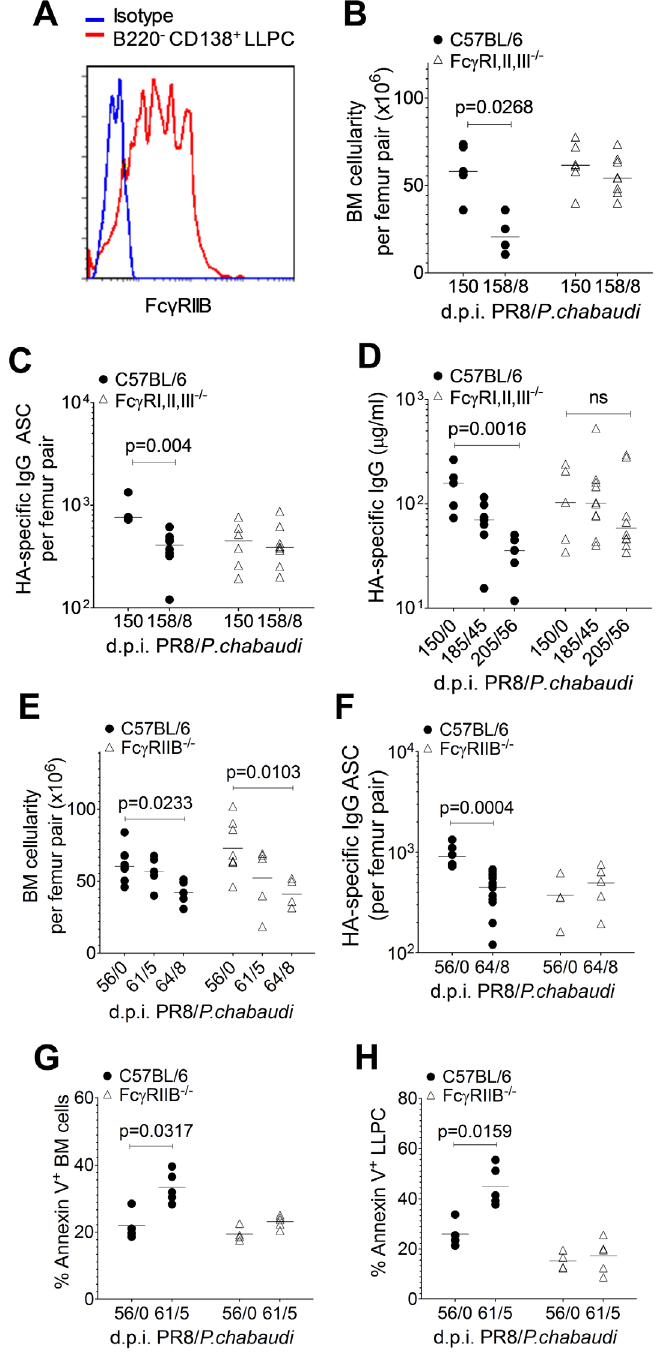
N ) and Fc c RI,II,III 2 / 2 ( D ) Figure 4. Loss of pre-existing humoral immunity to Influenza A virus is dependent on Fc c RIIB. Female C56BL/6 ( mice aged 8–10 weeks were infected by intranasal instillation of 250 HAU of PR8. 150 days later, mice were infected with P. chabaudi . A. Representative FACS plot showing the relative MFI of Fc c RIIB (CD32) expression on B220 2 CD138 + bone marrow LLPCs compared to an isotype control. B and C 8 days after P. chabaudi infection, bone marrow from femur pairs was obtained. B. Total bone marrow cellularity was determined N ): n=3 (d150/0) and 8 (d158/8)]. and C, HA-specific ASCs were quantified using ELISpot [Fc c RI,II,III 2 / 2 ( D ): n=6 (d150/0) and 8 (d158/8); C56BL/6 ( Data were pooled from two independent experiments. D. Venous blood was obtained from C56BL/6 and Fc c RI,II,III 2 / 2 mice on days 0, 35 and 56 of P. chabaudi infection and processed for serum. HA-specific IgG antibodies were quantified by ELISA. Data was obtained from one experiment N ): n=5 (d150/0), 7 (d185/35) and 7 (d196/56)]. E–H. 8–10 week old female [Fc c RI,II,III 2 / 2 ( D ): n=5 (d150/0), 10 (d185/35) and 10 (d196/56); C56BL/6 ( N ) and Fc c RIIB 2 / 2 ( D ) mice were infected by intranasal instillation of 250 HAU of PR8. 56 days later, mice were infected with P. chabaudi as C56BL/6 ( previously described. E. 5 and 8 days after P. chabaudi infection, bone marrow from femur pairs were obtained and total bone marrow cellularity was determined. F. 8 days after P. chabaudi infection, HA-specific ASCs were quantified using ELISpot. 5 days after P. chabaudi infection, % Annexin expression was determined on G, total bone marrow cells and H, bone marrow LLPCs. Data was obtained from one experiment [Fc c RIIB 2 / 2 ( D ): N ): n=3(d56/0), 5(d61/5) and 5(d64/8)]. Error bars indicate the median 6 S.E.M. and statistical values n=4(d56/0), 5(d61/5) and 5(d64/8); C56BL/6 ( were calculated using a two-tailed Mann-Whitney test. Non-significant values (P . 0.05) are not indicated on the graphs. doi:10.1371/journal.ppat.1003843.g004 PLOS Pathogens |